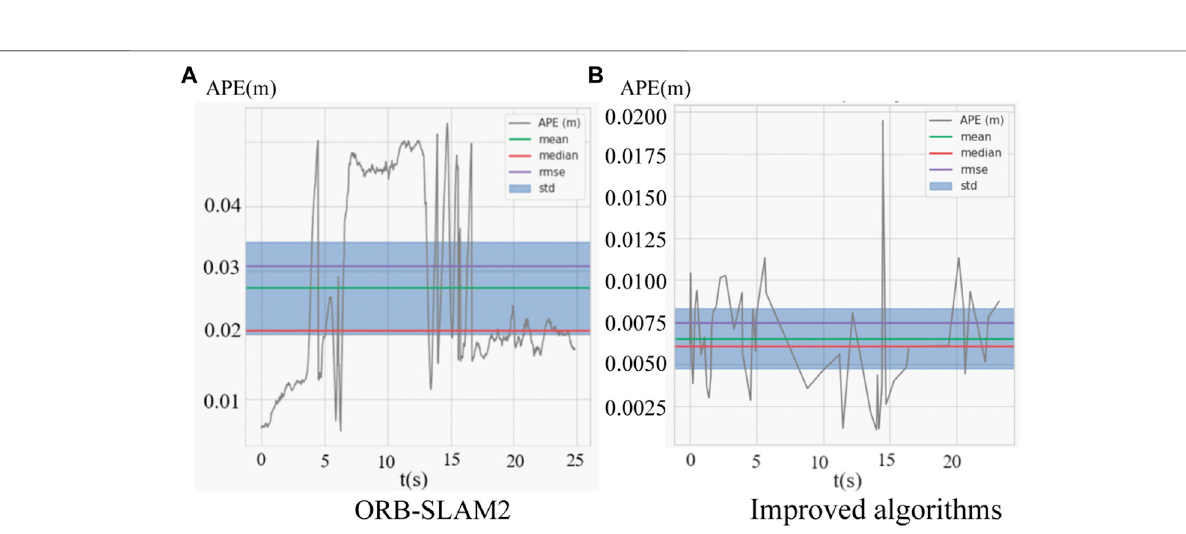
Frontiers in Energy Research |